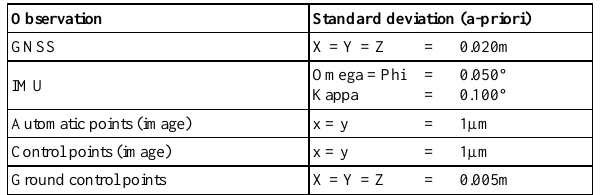
Table 3: Start conditions of aerial triangulations